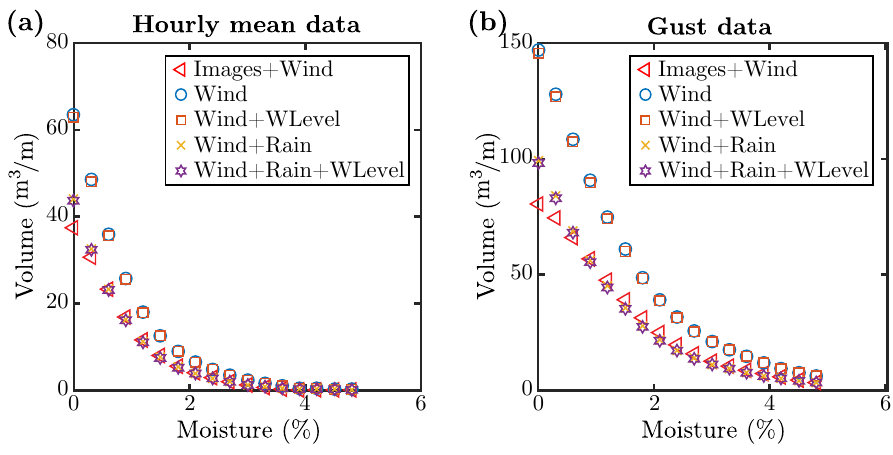
Figure 13. Transport quantification (dune volume increase) for various surface moisture content, for ( a ) hourly mean and ( b ) gust wind speed for the period 18 March 2009–11 March 2010. Volume was calculated using: (1) Equation (2), considering images, i.e., hours of transport occurrence and wind speed (red triangles) and wind speed data (blue circles); (2) Equation (6), considering wind and water levels (red squares); wind and rain (yellow crosses); and wind, rain and water levels (purple stars). The red triangles for hourly mean and gust wind speed correspond to the blue diamonds and red circles in Figure 12 respectively.